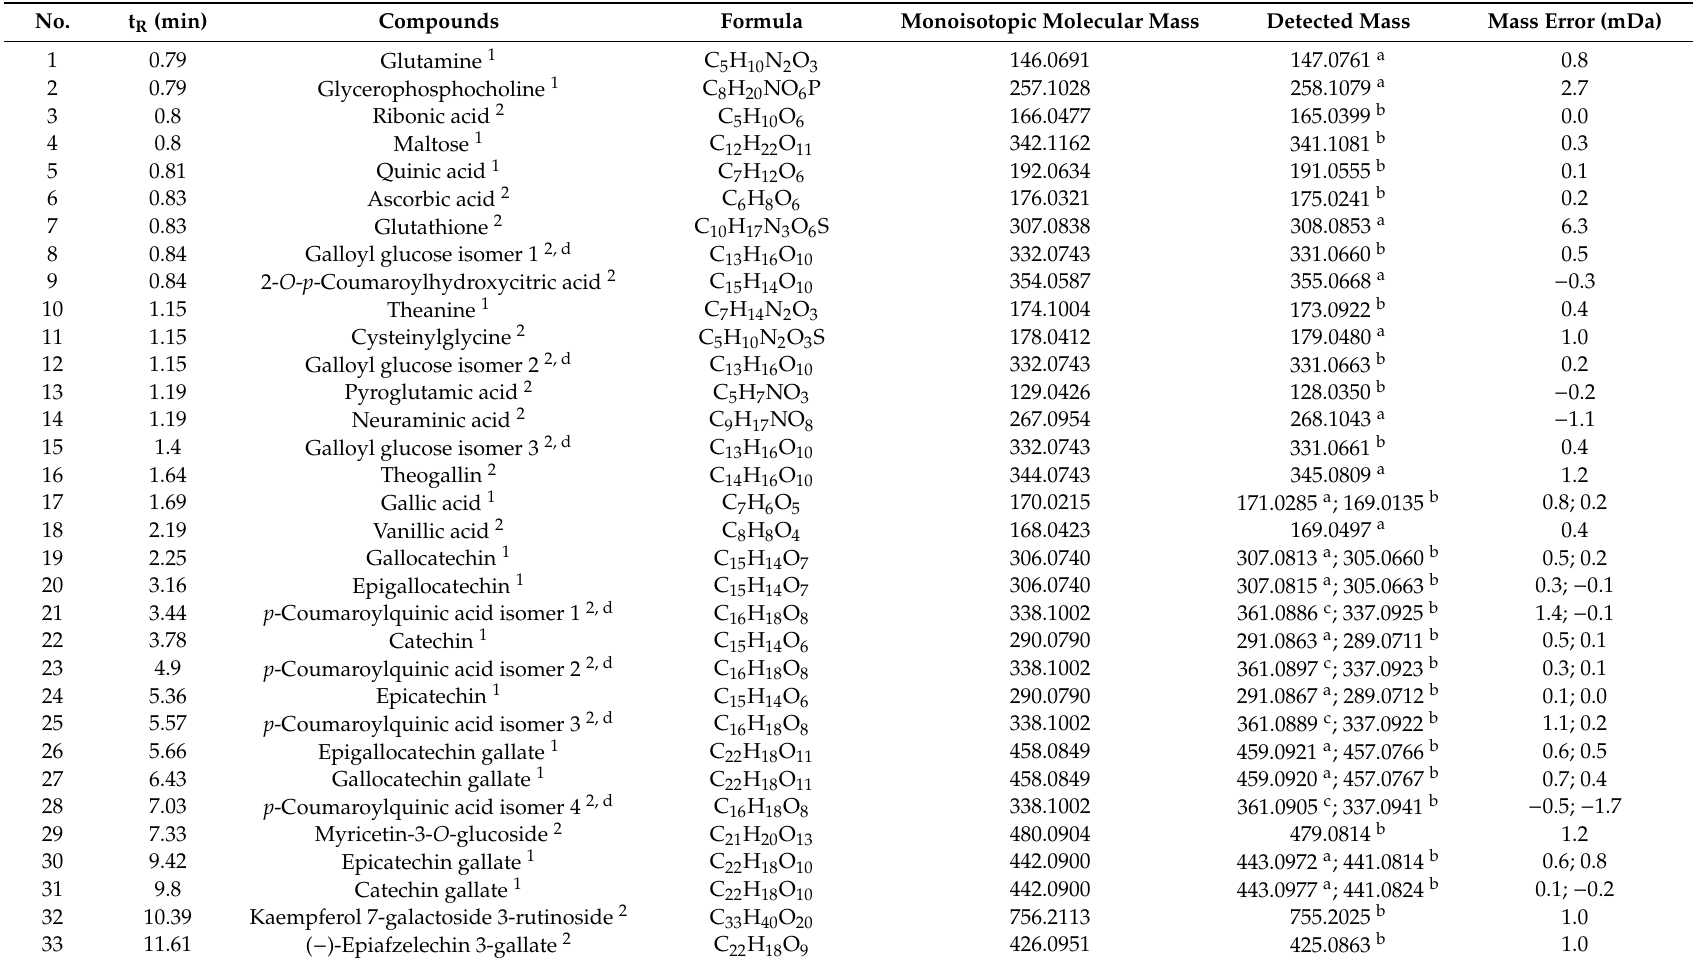
Table 1. Identification results of di ff erential metabolites in green tea infusions under di ff erent brewing